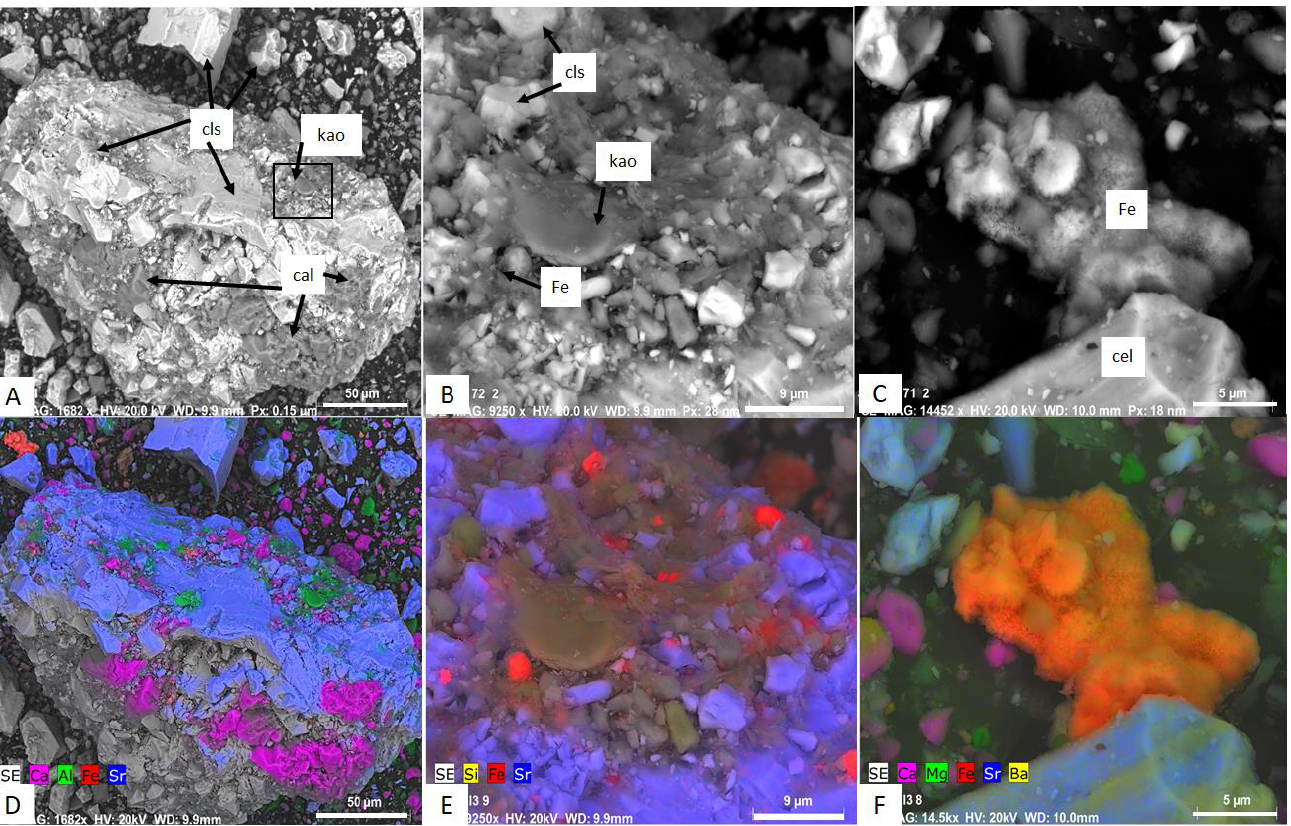
Figure 3. Scanning electron microscopy of E60 sample. ( A – C ) Representative images of mineral (BS mode) showing celestine crystals with brighter illumination (electron dense) and calcite and silicate minerals with lower illumination. ( D – F ) EDX maps showing distribution of relevant chemical elements (Sr in blue, Ca in purple, Ba in yellow, Al in green, and Fe in red) superimposed onto SEM images shown above. cls: celestine; cal: calcite; kao: kaolinite; Fe: iron oxides and hydroxides.